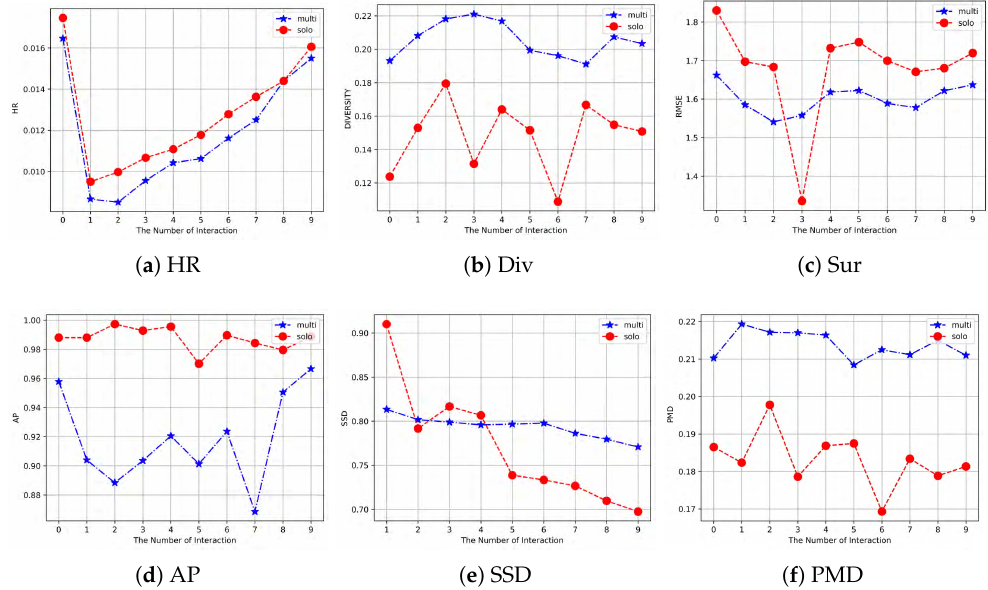
Figure 8. The recommendation performance of the two algorithms on six metrics when performing interactions in the Kindle